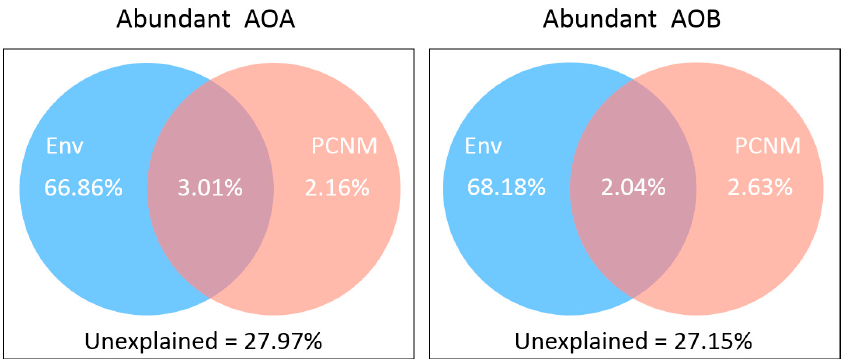
Figure 6. Variation partitioning of ammonia-oxidizing microbe communities by environmental variables (Env) and spatial factors (PCNM) for abundant communities.